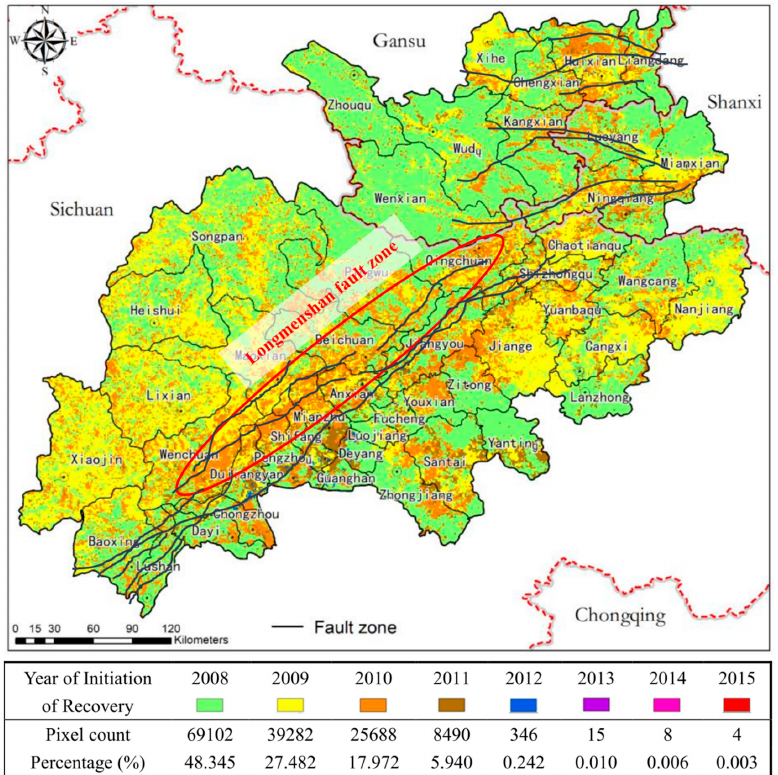
Figure 7. Mapping about the year vegetation recovery was initiated in the study area. Fault zone data referred to Atlas of Mountain hazards and soil erosion in the Upper Yangtze [82].